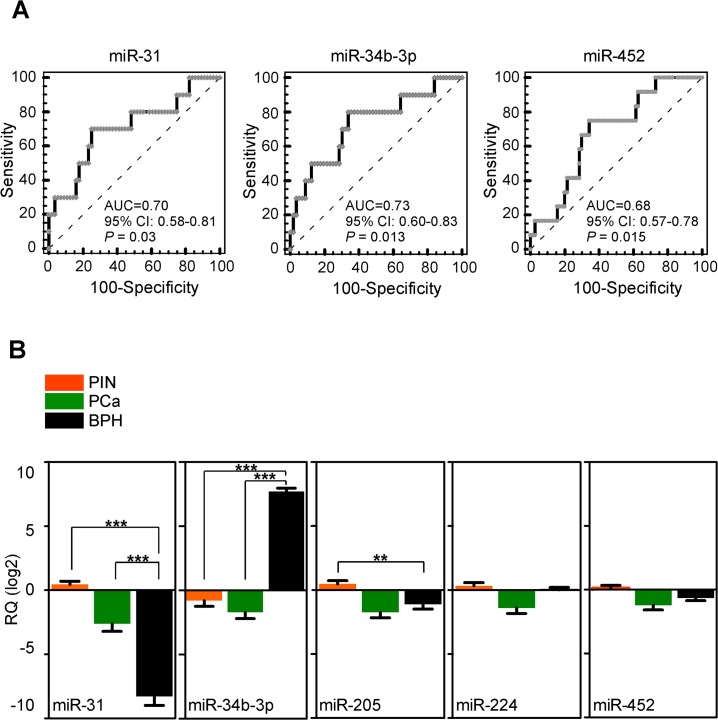
miR-34b-3p is a biomarker of prostate cancer progression.
A) Receiver operating characteristic (ROC) curves were used to test the accuracy of miRNAs to identify patients who had PSA failure during follow-up. AUC; Area under the curve; CI, Confidence interval. B) MiR-31, 34b-3p, 205, 224 and miR-452 expression was evaluated by qPCR in unpaired pre-cancerous glands (PIN, n = 50), neoplastic prostate lesions (PCa, n = 66), or benign hyperplastic tissues (BPH, n = 10). **, p = 0.0027; ***, p<0.001, all by Mann-Whitney test. Bars, mean±SEM. RQ, relative miRNA quantity.